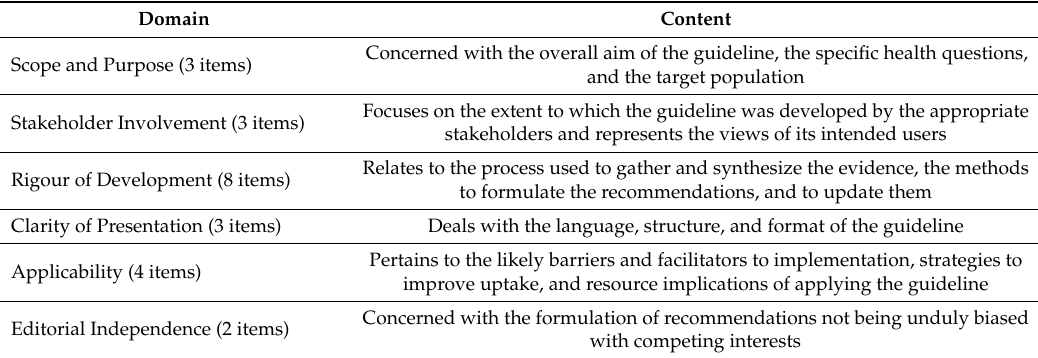
Table 1. Clinical guideline quality domains used in the Appraisal of Guidelines for Research and Evaluation II (AGREE II)